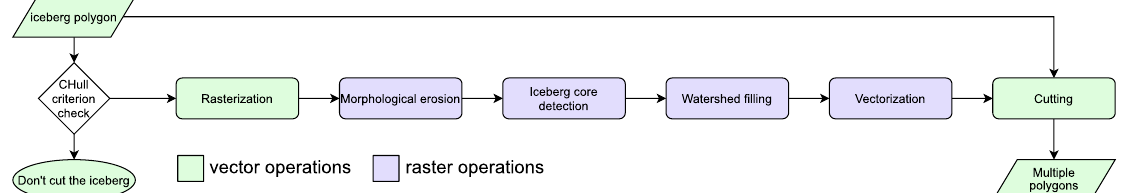
Figure 6. Procedure of watershed cutting of a single